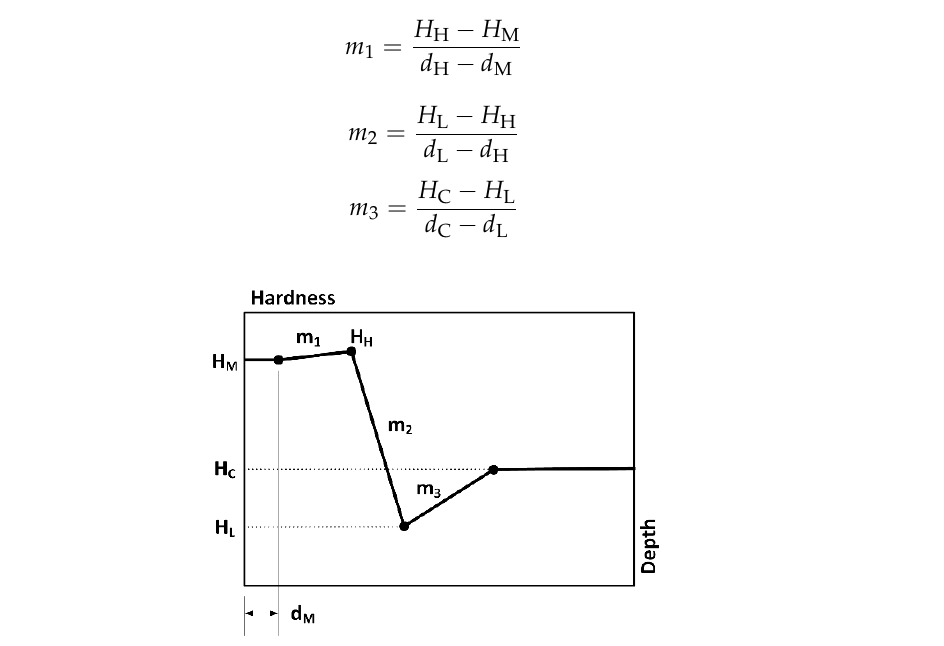
Figure 6. Geometrical technique for extracting attributes.